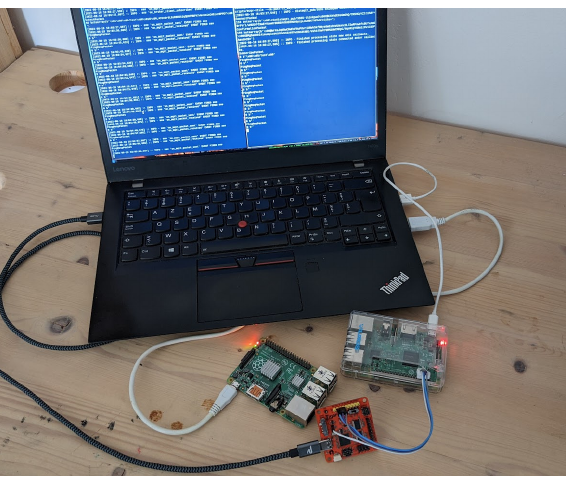
Figure 4. Testbed composed of a Raspberry PI 3B acting as the publisher connected to a laptop via a UART adapter that host the MQTT broker, a Raspberry Pi B+ acting as the